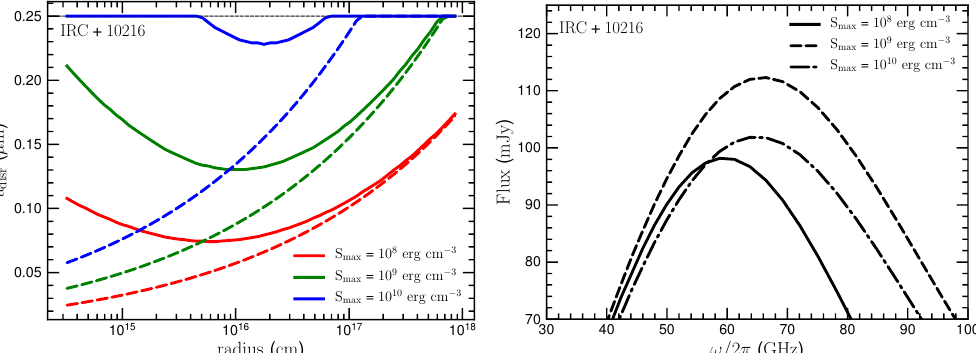
Figure 24. Left panel: Disruption size of dust grains versus distance from the star in the circumstellar envelope (CSE) of IRC + 10216 for the different tensile strengths ( S max ). The initial maximum grain size is chosen as 0.25 µ m. Right panel: Emission flux from spinning nanoparticles in CSEs around C-rich star (IRC + 10216, top). We adopt M d / g = 0.01, η = (Draine and Li [90]), and Y Si = 0.2 (Hoang et al.